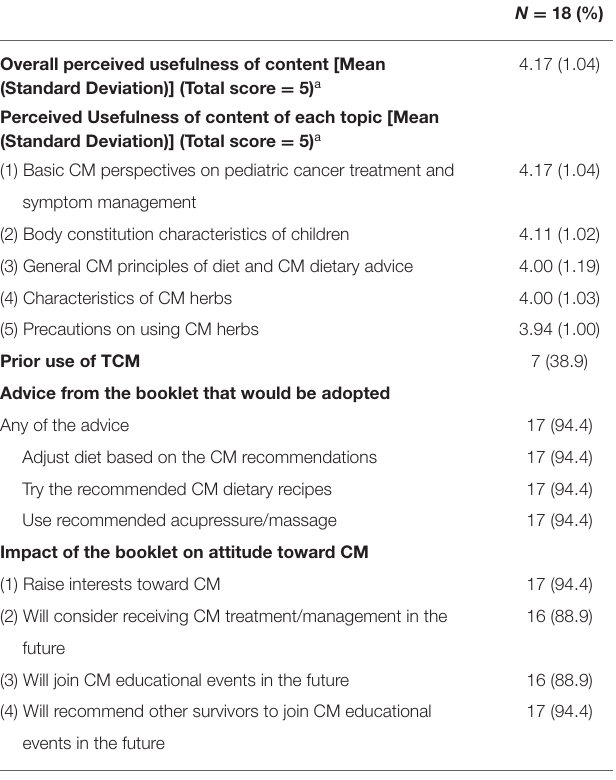
TABLE 2 | Results of the feedback survey of the educational booklet.